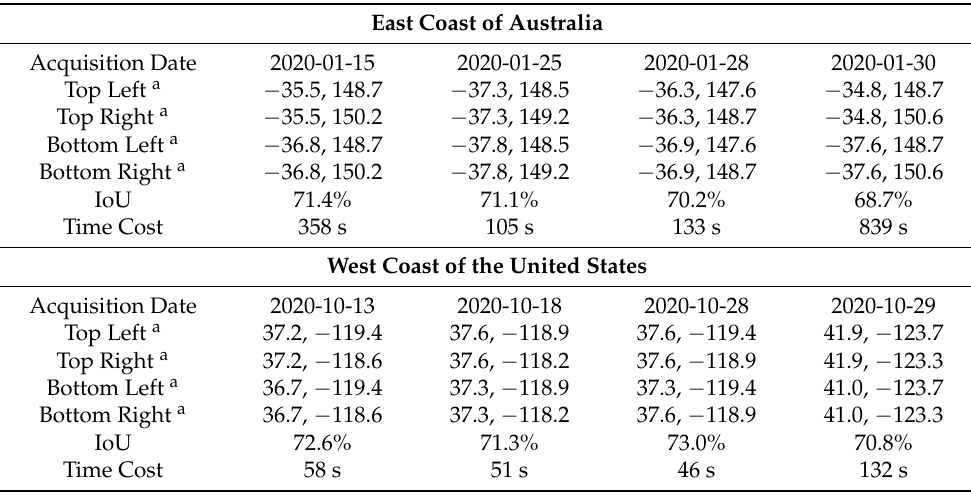
Table 4. Detection accuracy and processing efficiency of the automated